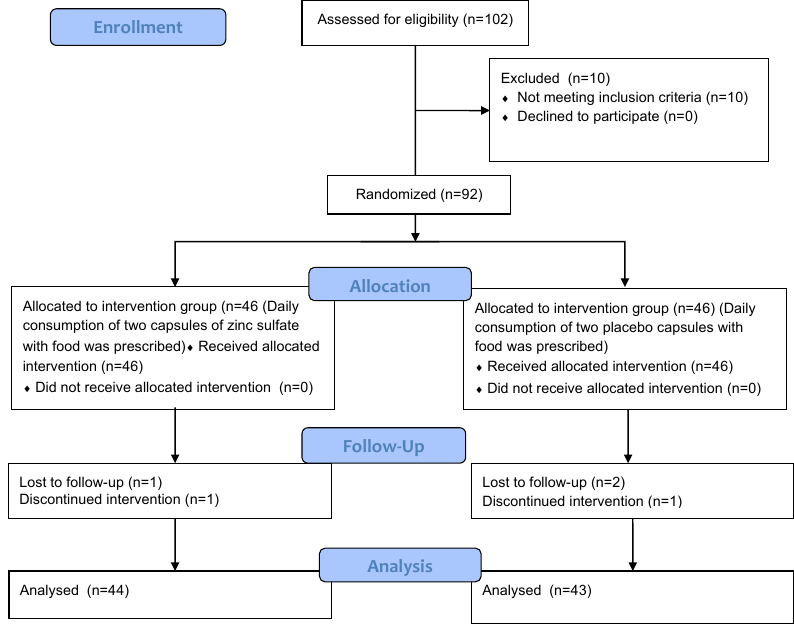
Figure 1. Consort flowchart of patients.